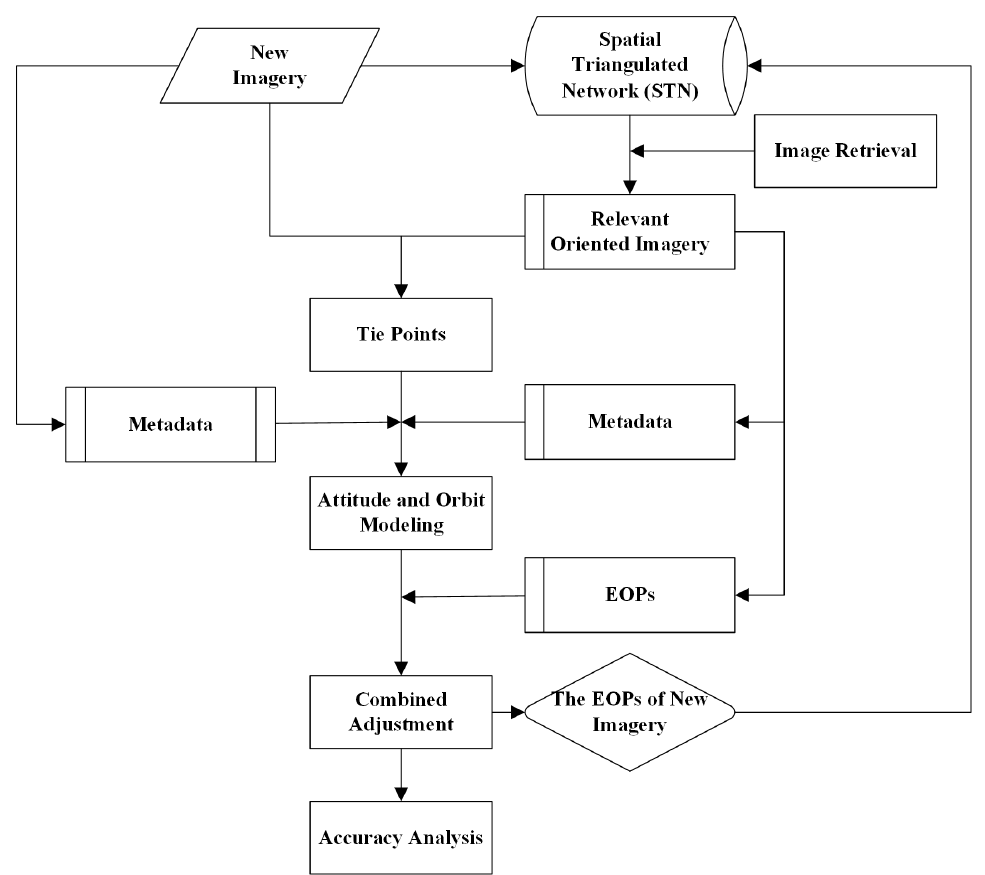
Figure 2. Workflow of georeferencing using the oriented imagery without